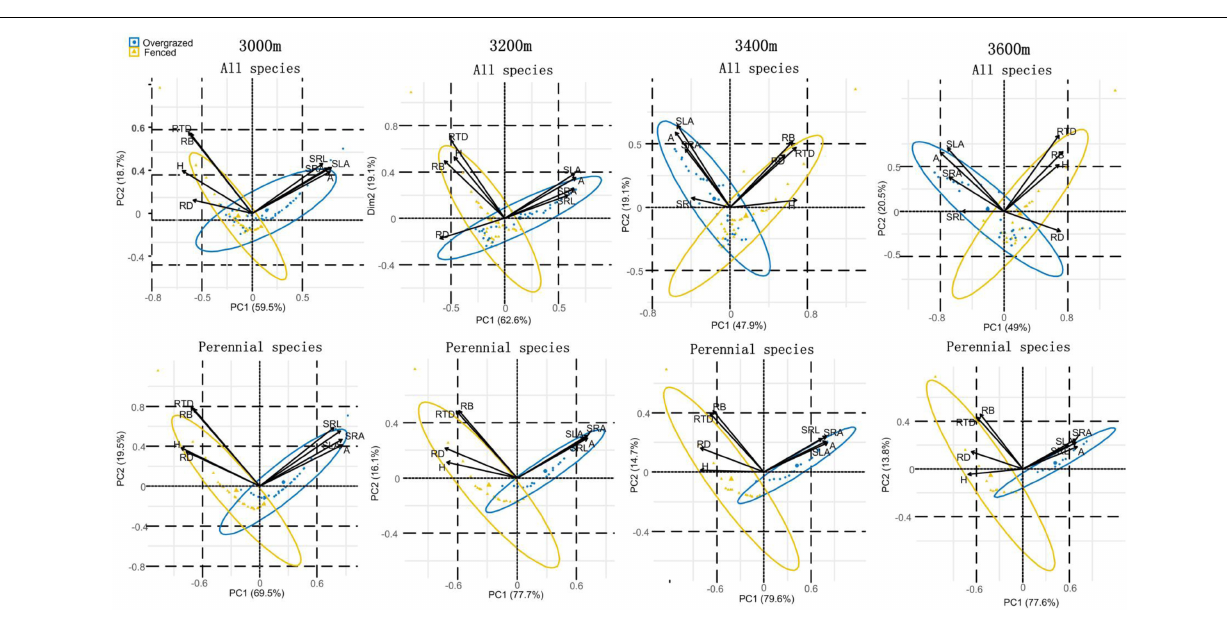
select species to re-design communities to perform restoration of overgrazed